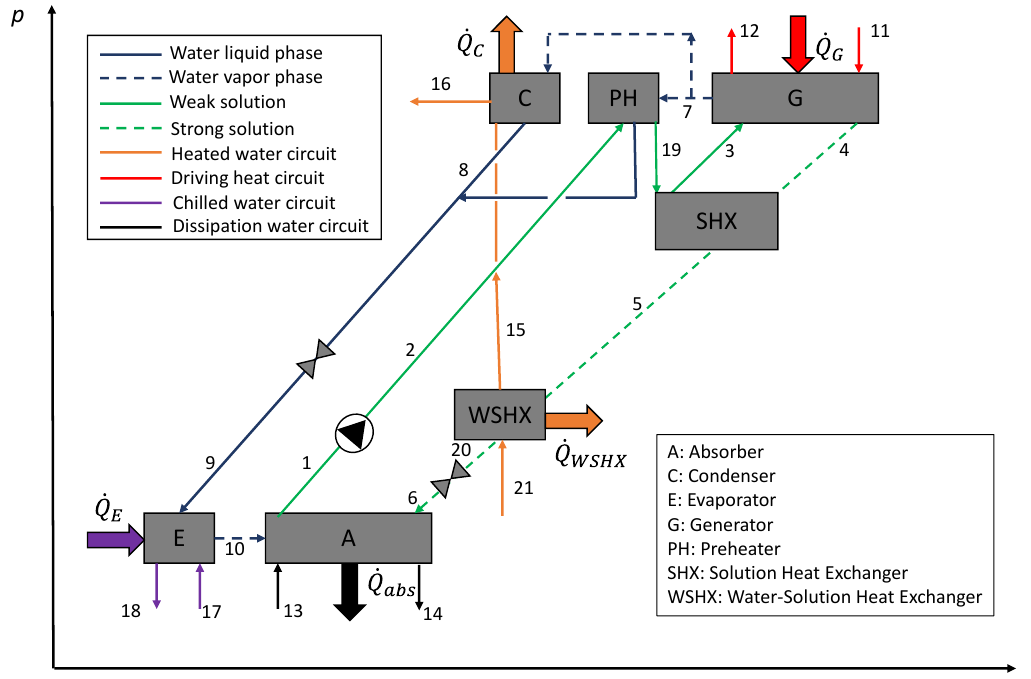
Figure 1. Proposed single-effect H 2 O/LiBr absorption heat pump for combined heating and cooling production. Apart from the added new components (i.e., PH and WSHX), the operational condi- tions of the proposed H 2 O/LiBr AHP (Figure 1) are considerably altered in contrast to the conventional single-effect H 2 O/LiBr chiller. Figure 2 illustrates the Dühring plot of the single-effect H 2 O/LiBr AHP with the recovery of condensation heat, in which its cyclic process is denoted by red lines (stream 1 to 10, stream 19 and 20).